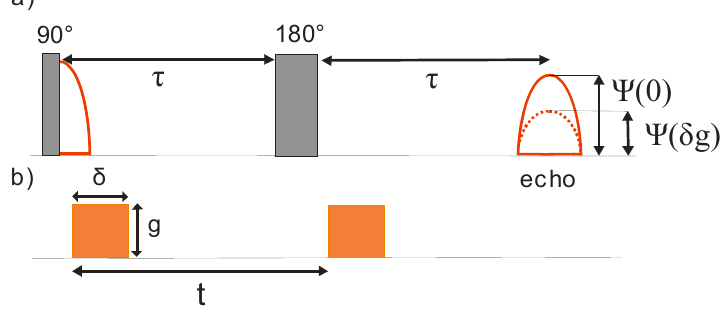
Figure 1. Pulse sequence for generating the NMR Hahn echo with ( a ) the two observable main signals (the free induction decay following the π pulse, and the Hahn (spin) echo) and ( b ) the field gradient pulses, applied in the basic PFG NMR experiment for self-diffusion